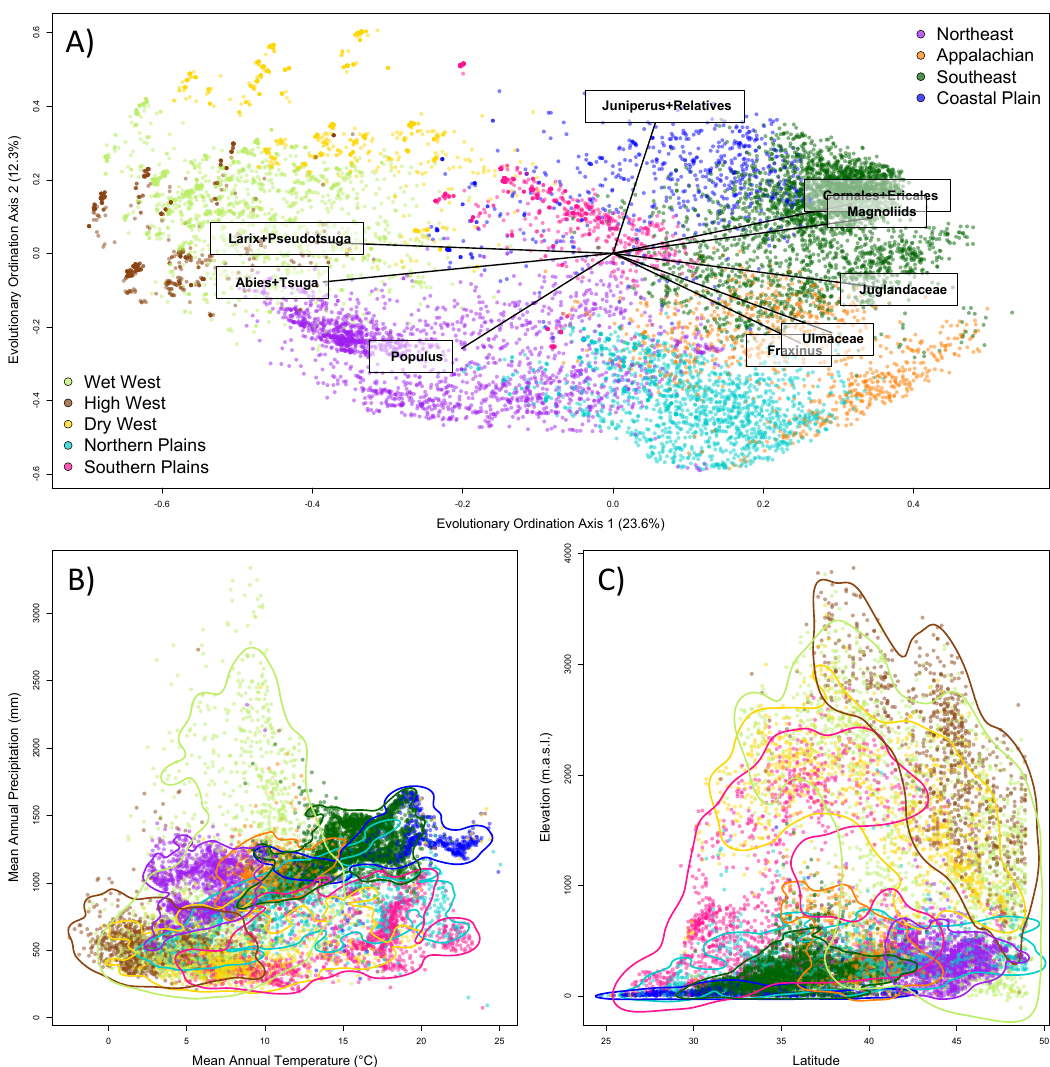
Figure 4. Distribution of nine main evolutionary groups of tree assemblages in the contiguous United States across: ( A ) an ordination space based on shared evolutionary history, with the influence of the key clades highlighted; ( B ) climatic space; and ( C ) elevation and latitude. The majority of grid cell assemblages sampled at least 50 individuals (11,547 of 13,207 assemblages or 87%), and were therefore included in calculations of assemblage lineage diversity (ALD). We estimated ALD metrics for each assemblage, including constructing lineage through time (LTT) plots for each to calculate the time integrated lineage diversity (TILD). We show a sample of these LTT plots for each evolutionary group in Figure 5. There is clear variation across groups in when they accumulate lineage diversity. The Northern Plains group is composed entirely of eudicot angiosperms, and therefore most assemblages only have a single lineage (a log value of 0 on y-axis) until the eudicots begin to diversify ∼ 120 Ma. An entirely contrasting pattern can be found in assemblages of the Dry West group, which have multiple lineages of gymnosperms, and thus have high lineage diversity deep in time. However, these assemblages are relatively poor in angiosperms and so do not achieve the same number of lineages in recent time periods as the Northern Plains group. The eastern groups have the highest number of lineages in recent time slices and also tend to have high lineage diversity deep in time, except for the Appalachian group which is relatively poor in